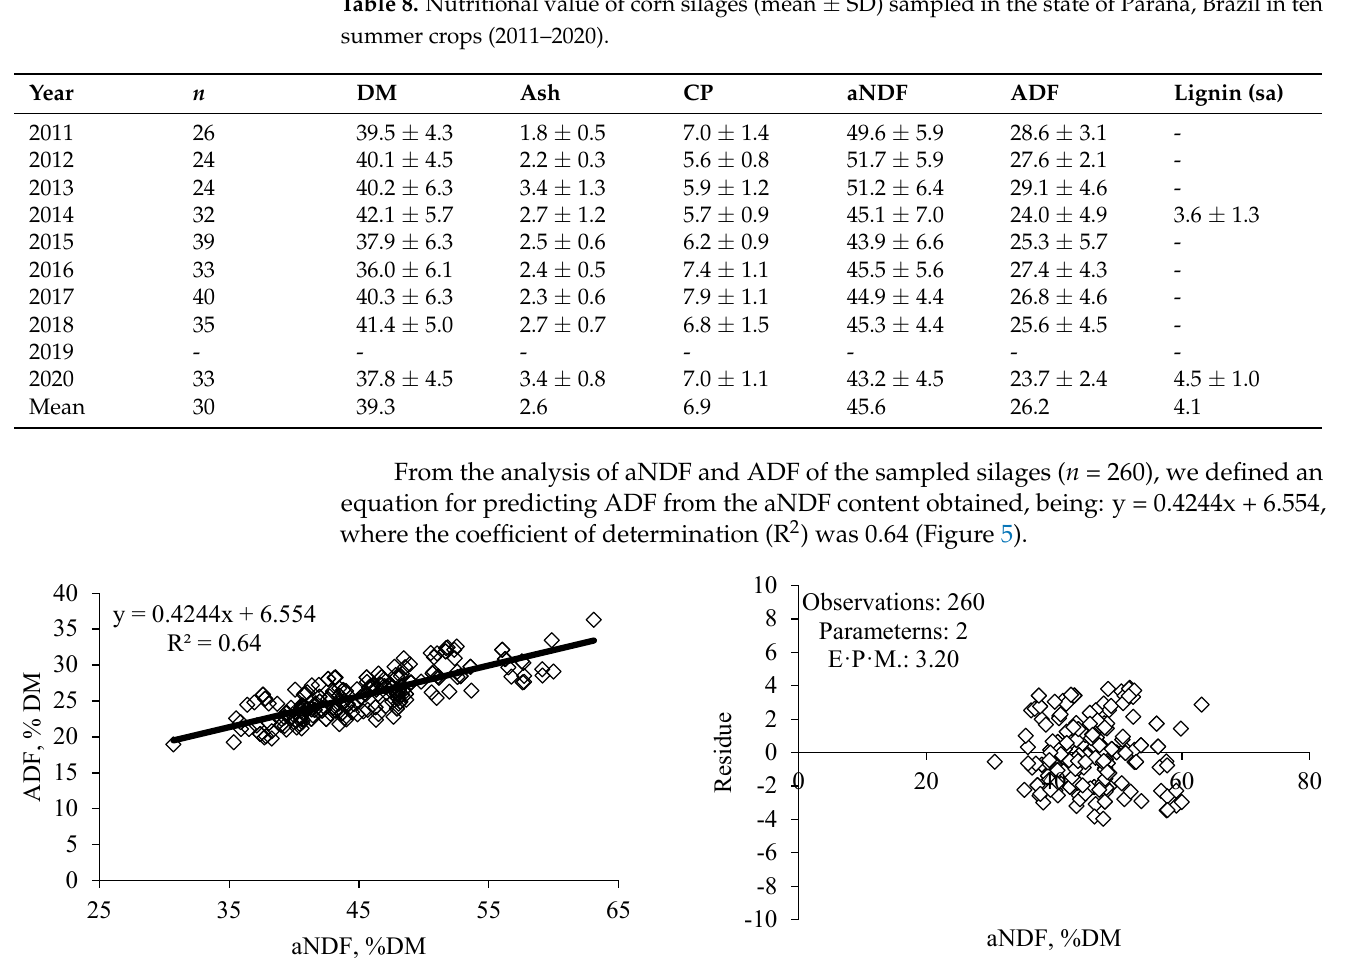
Figure 5. Plotting the equation fit and residues for estimating the ADF content of corn silage through aNDF. Data from 260 samples, collected from 65 farms in 18 municipalities in the state of Paraná, Brazil between 2011 and 2019.